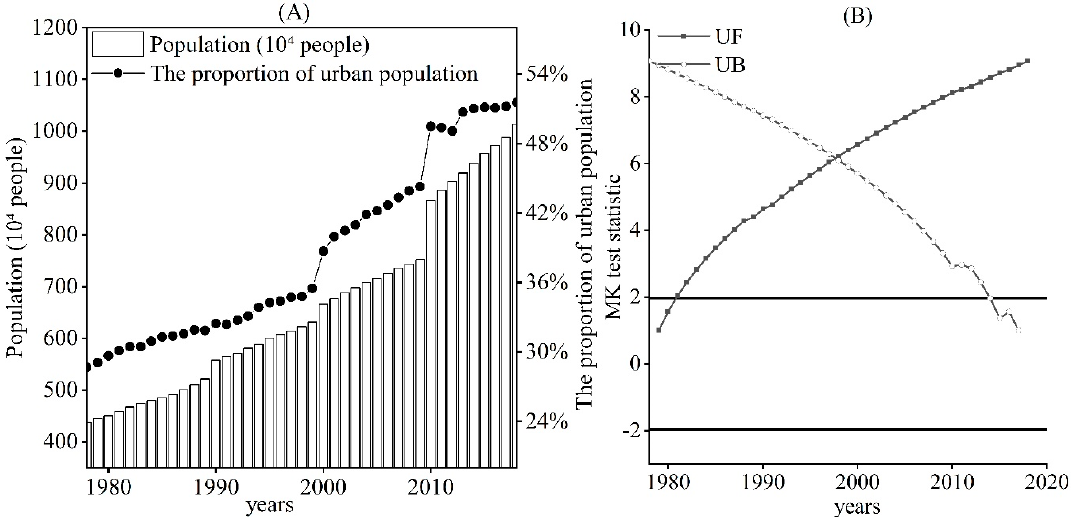
Figure 3. The proportion of population ( A ) and urban population and the Mann–Kendall test statistics of population urbanization rate ( B ) in Zhengzhou from 1978 to 2018.